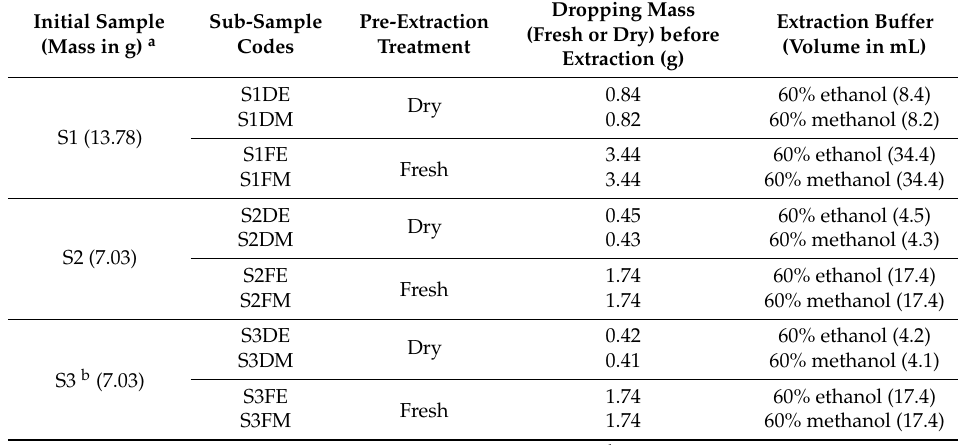
Table 2. Pattern of method combinations and characteristic of samples